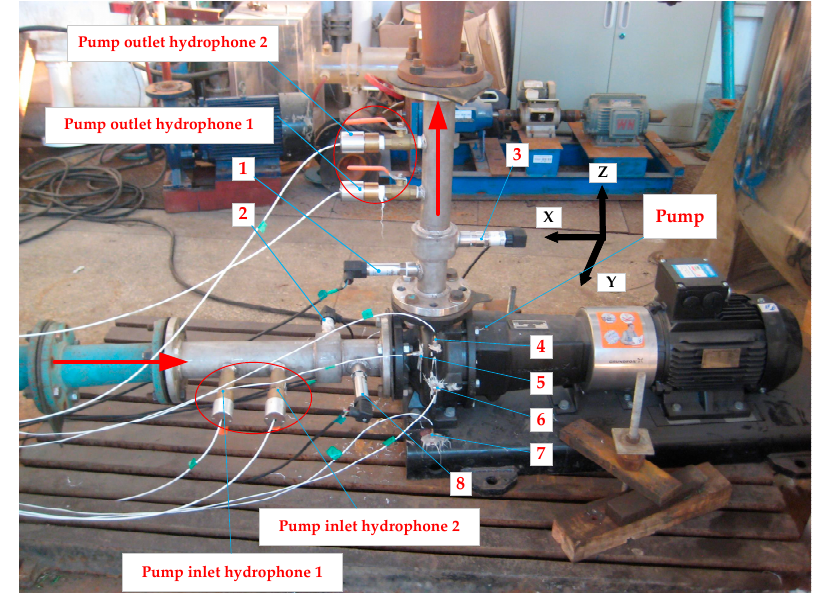
Figure 3. Installed positions of the hydrophones. (1) Pump outlet pressure transmitter 1; (2) pump inlet pressure transmitter 1; (3) pump outlet pressure transmitter 2; (4) accelerometer 3, Z direction; (5) accelerometer 1, X direction; (6) accelerometer 2, Y direction; (7) accelerometer 4, on the base; (8) pump inlet pressure transmitter 2.